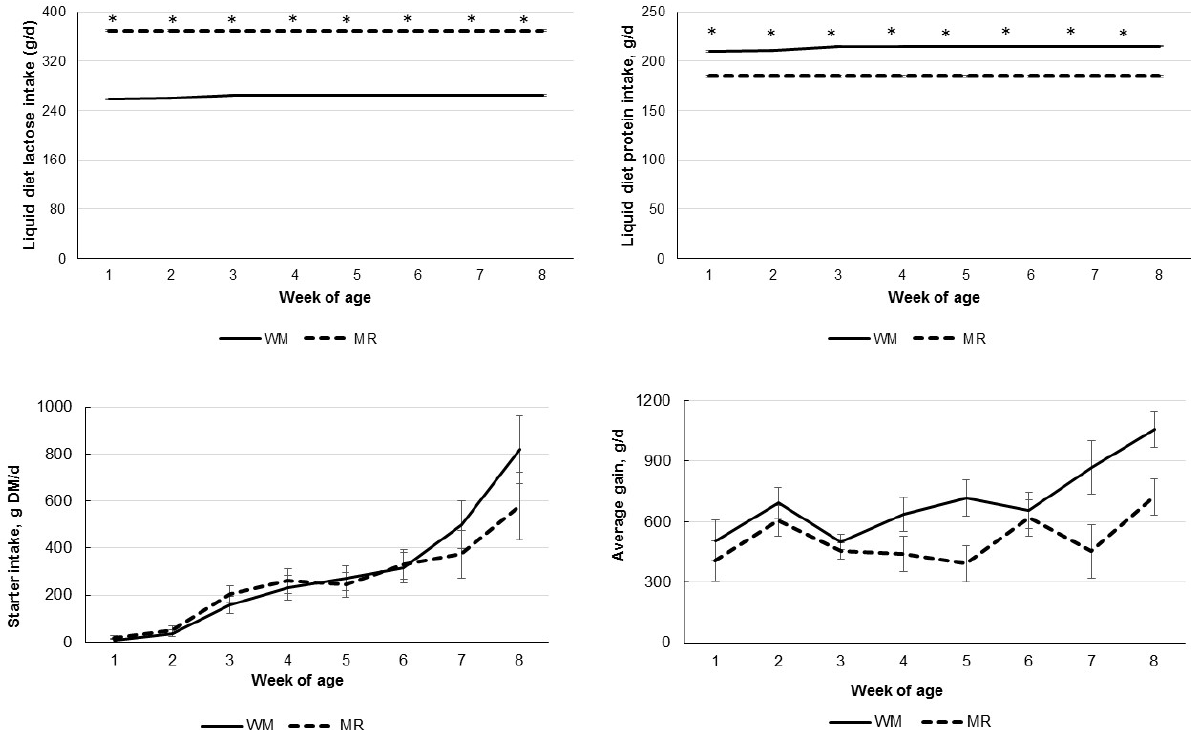
Figure 1. Liquid diet lactose and protein intake, starter intake, and average daily gain according to the age of calves fed whole milk (WM) or milk replacer (MR) as their liquid diet. * Denotes difference between liquid diet with p < 0.05. Table 2. Intake, performance, and body measurements of dairy calves fed whole milk (WM) or milk replacer